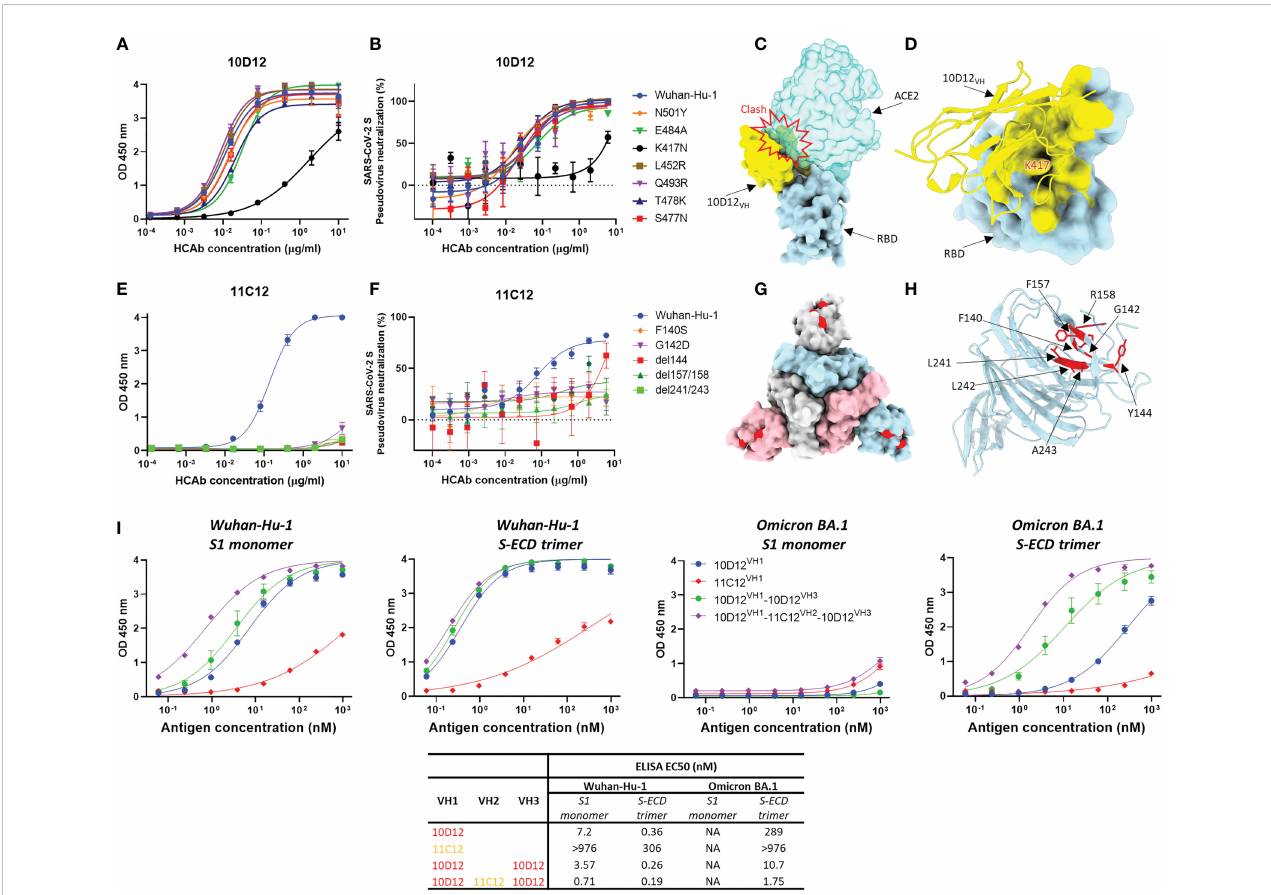
FIGURE 4 Binding sites of 10D12 and 11C12 on SARS-CoV-2 S protein trimer and ELISA binding of bi-, tetra- and hexavalent HCAbs to S antigens of ancestral and Omicron BA.1 (A) ELISA binding of 10D12 to ELISA plate-coated SARS-CoV-2 S1 (Wuhan-Hu-1) or S1 mutants harboring the indicated RBD mutations. (B) Neutralizing activity of 10D12 against pseudovirus with SARS-CoV-2 (Wuhan-Hu-1) S or S carrying indicated substitutions. (C) Surface representation of the 10D12-bound RBD overlaid with the RBD-bound ACE2 (PDB ID: 6M0J). (D) Surface representation of the SARS-CoV-2 S RBD and cartoon representation of 10D12. The 10D12 epitope residues, identi fi ed using PDBePISA, are colored yellow. (E) ELISA binding of 11C12 to ELISA plate- immobilized with S1 (Wuhan-Hu-1) or S1 variants carrying the indicated NTD mutations. (F) Neutralizing activity of 11C12 against pseudoviruses with SARS-CoV-2 (Wuhan-Hu-1) S or S variants harboring the indicated mutations. (G) Surface representation of SARS-CoV-2 Spike trimer (PDB ID: 6XR8) with the 11C12 binding site highlighted in red. (H) Close-up view showing the key residues for 11C12 binding. (I) Binding of monomeric S1 or trimeric S- ECD of ancestral (Wuhan-Hu-1) SARS-CoV-2 and Omicron BA.1 to plate-immobilized bivalent (10D12 and 11C12), tetravalent (10D12 VH1 -10D12 VH2 ) or hexavalent (10D12 VH1 -11C12 VH2 -10D12 VH3 ) HCAbs. OD 450 nm, optical density at 450 nm. Error bars indicate SD between two independent